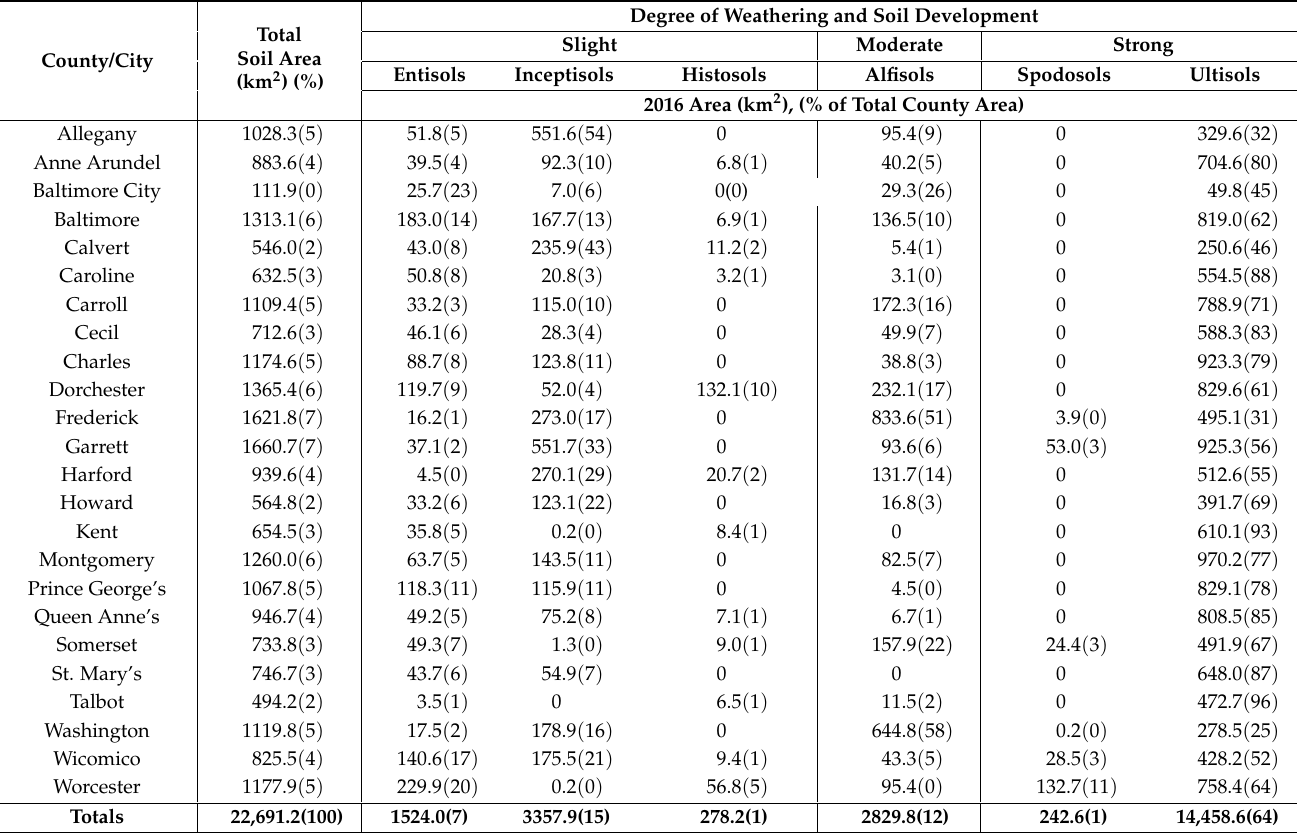
Table 3. Areas of soil orders by county in Maryland (USA) from the Soil Survey Geographic (SSURGO) Database